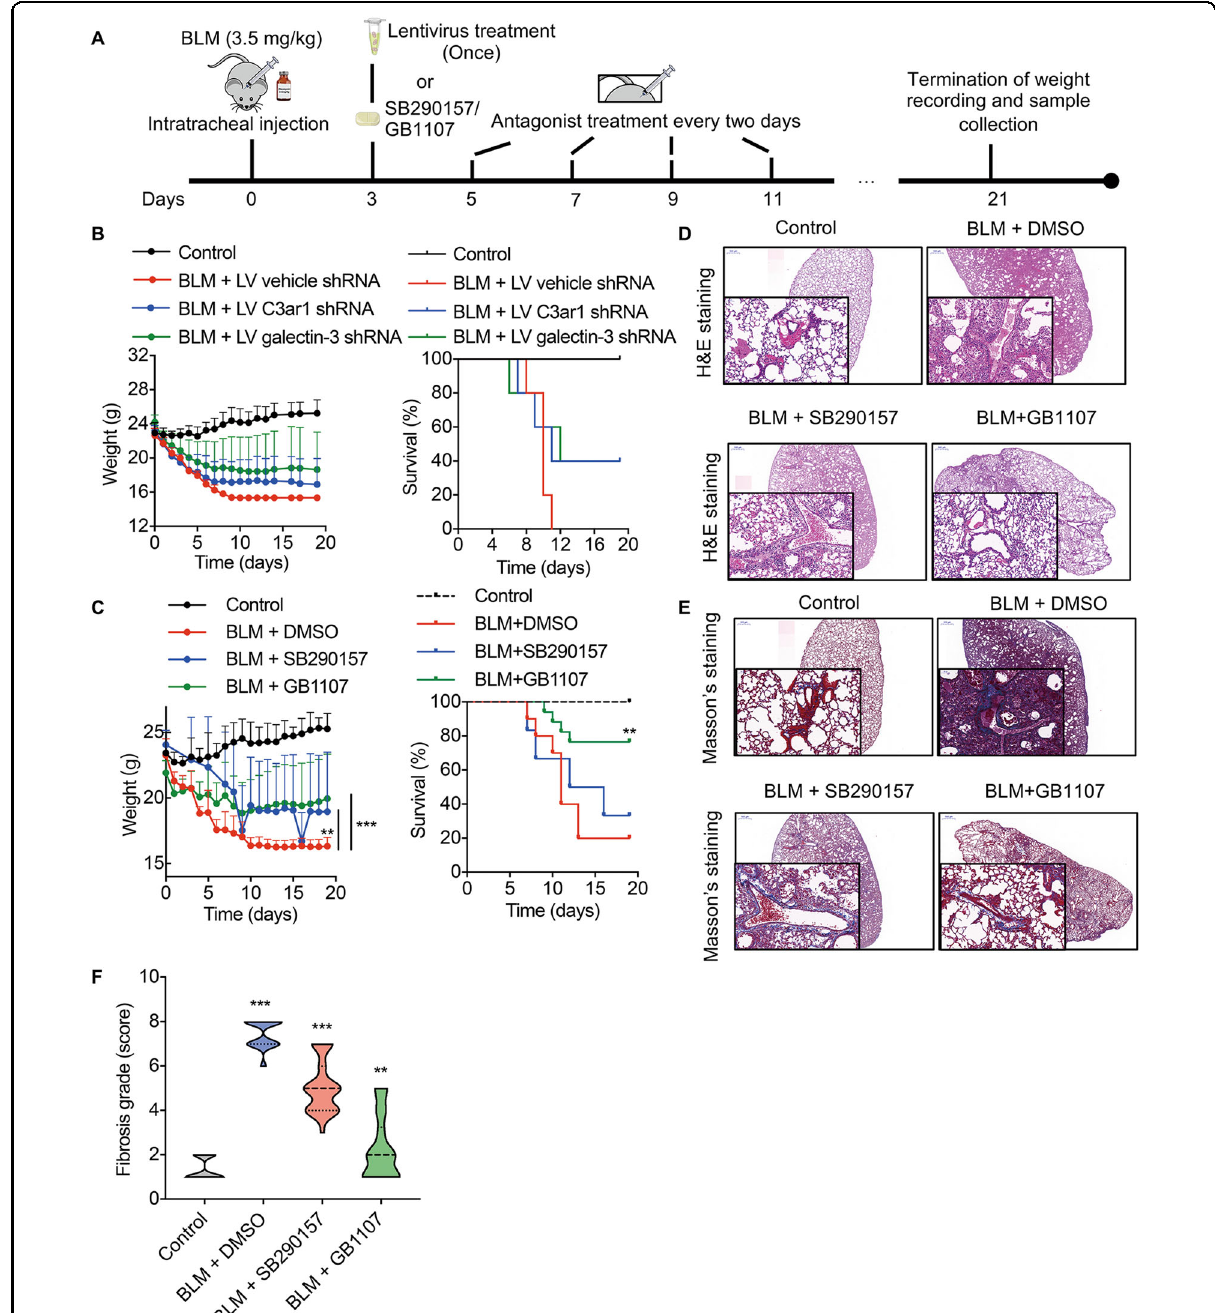
Fig. 4 Alleviation of pulmonary fi brosis by targeting C3ar1 and galectin-3 in vivo. A Schematic diagram showing the functional exploration of C3ar1 and galectin-3 in IPF using lentivirus and galectin-3 interference (shRNA group), respectively. Alternatively, antagonists were used to block the binding af fi nity of C3a and galectin-3 (antagonist group). B , C Body weight and survival of IPF mice with galectin-3 shRNA lentivirus ( B ) (LV C3ar1 shRNA and LV galectin-3 shRNA, n = 5) or antagonists ( C ) (SB290157: antagonist of C3ar1; GB1107: antagonist of GB1107, n = 6). D , E HE and Masson ’ s trichrome staining of mouse lung sections following lentivirus or antagonist treatments. Scale bar = 500 μ m (global view) or 50 μ m (detailed view). F Semiquantitative morphological index/scoring of lung sections. The grade ranges from 1 (normal) to 8 (complete fi brosis). n = 30 for each group; * p < 0.05, ** p < 0.01, *** p <